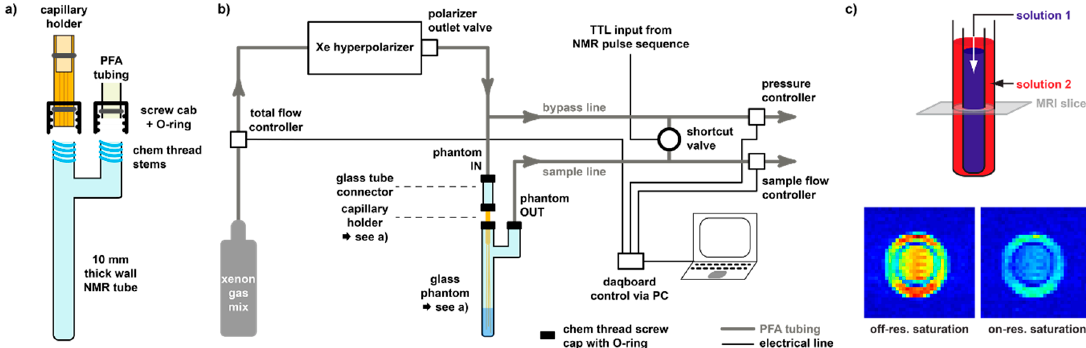
Figure 4. Setup for Xe-NMR of supramolecular systems in solution. ( a ) Sample holder for dispersion of hp 129 Xe into solution. ( b ) Setup illustrating the interplay between the hyperpolarizer, the connected sample holder, and the valve and pressure control via a PC and the NMR pulse sequence. For more details, see [124]. ( c ) Double phantom setup with exemplary MRI data showing a stronger saturation response for the inner compartment with a Xe host.